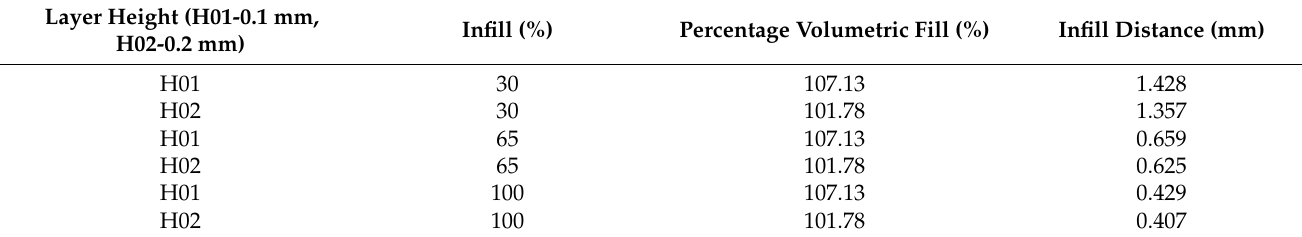
Table 2. Initial settings for the PrusaSlicer